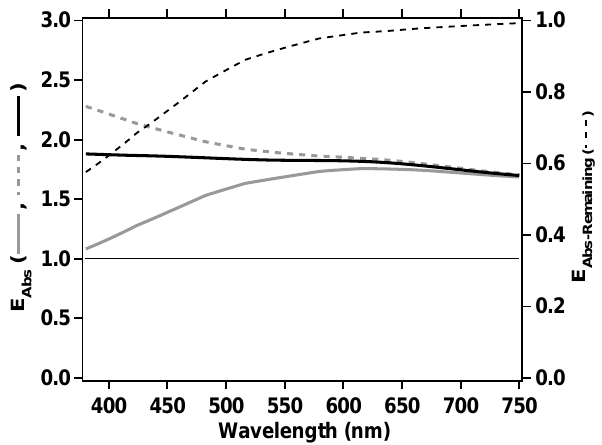
Fig. 3. Example of calculated E Abs for a BC core and C Clear shell ( E Abs − CL , solid black), BC core and C Brown shell ( E Abs − BR , dashed gray) and BC core and C Brown shell with C Brown absorption contribution removed ( E Abs − BR − X , solid gray). The reduction in the absorption enhancement in going from a clear to an absorbing coating, E Abs − Remaining , is shown as the dashed black (right axis). This is for a system having a 300nm diameter core and a 500nm shell